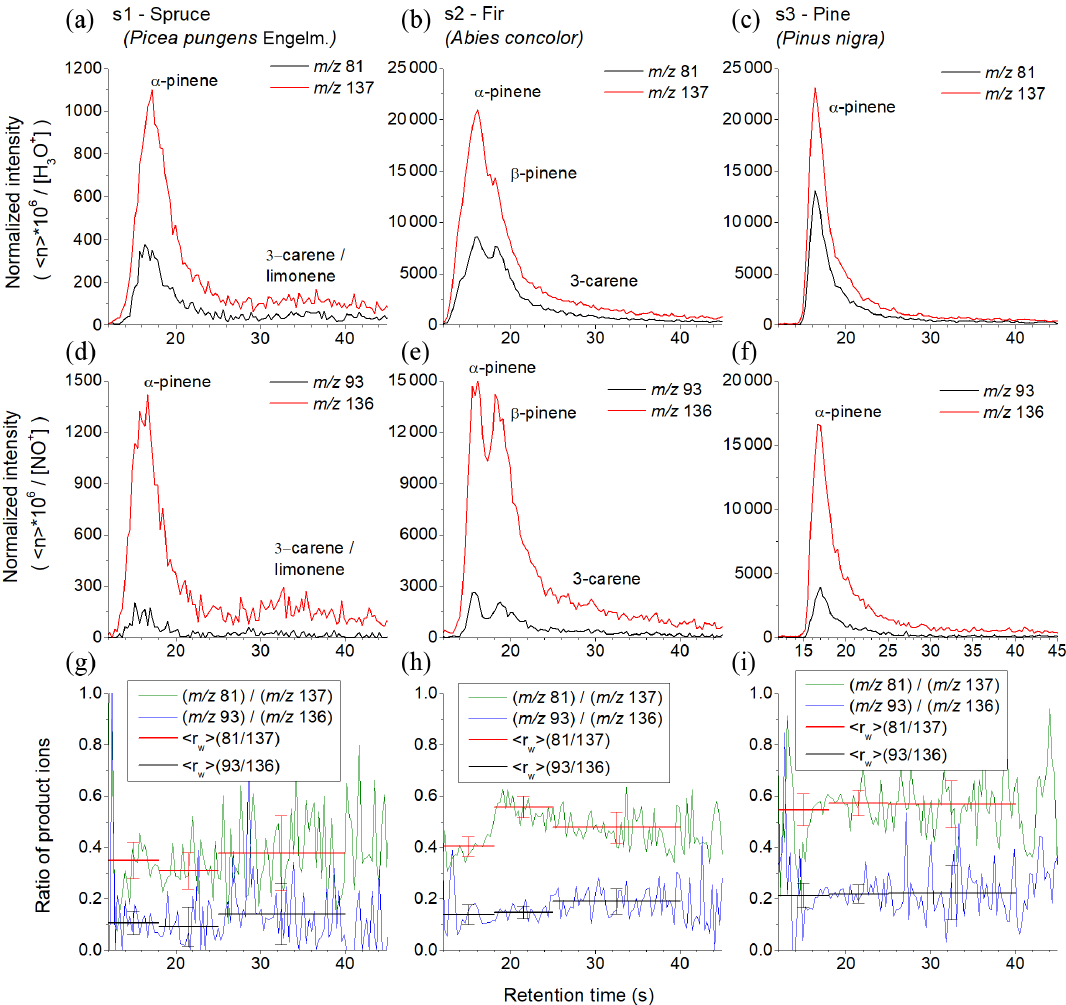
Figure 5. Chromatograms derived using the product ions for the reactions of H 3 O + (a, b, c) and NO + (g, h, i) reagent ions with monoterpenes obtained for the three investigated pine tree samples (s1, s2 and s3) using the MXT-1 column. The signal intensities are the analyte ion count rates normalized to a reagent ion count rate of 10 6 s − 1 . The black and red curves represent C 6 H + ( m/z 81) and C 10 H + ( m/z 137) product 9 17 ions for H 3 O + and C 7 H + ( m/z 93) and C 10 H + ( m/z 136) product ions for NO + reagent ions. The lower row shows calculated ratios of 9 16 product ions r i for both reagent ions (green and blue curves) and for peaks areas calculated r w (red and black). Table 4. Calculated concentrations of monoterpenes (in ppmv and %) in the headspace of coniferous twigs in selected regions of chro- matogram obtained using the MXT-Volatiles column at a column temperature of 40 ◦ C, using an injection time of 6s and a column flow of 3sccm. Sample Concentration (ppmv, %) α